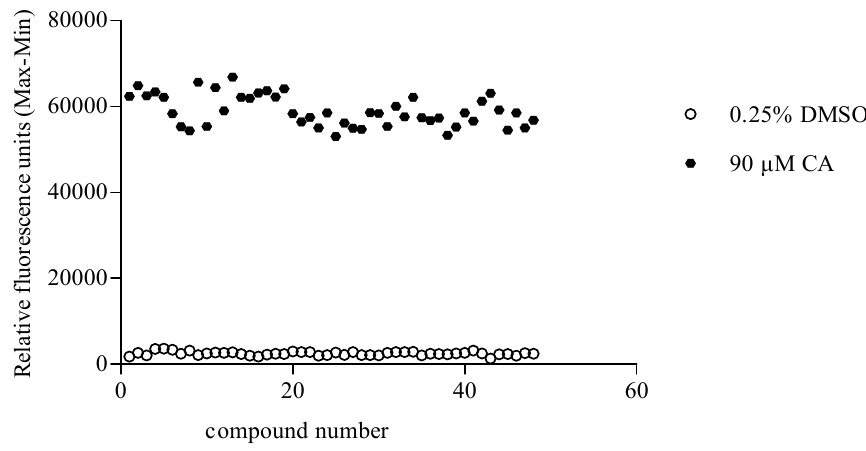
Figure 2. Z' factor plot of screening for TRPA1 agonists using the calcium mobilization assay in 96-well plate. Ninety micromoles of CA and 0.25% DMSO were defined as the positive and negative control, respectively. The Z' value was determined as 0.78.